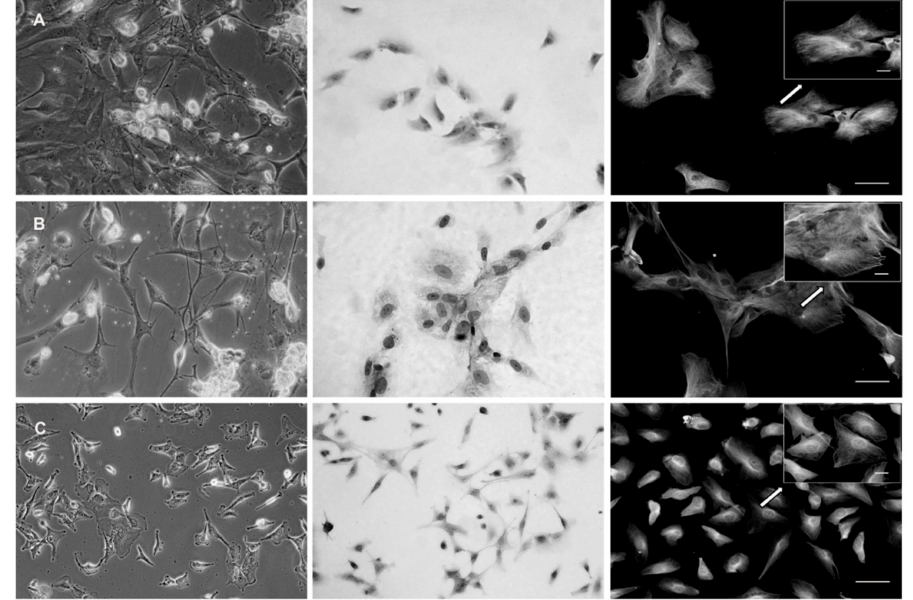
Figure 2. Phase contrast ( left ), haematoxylin and eosin ( middle ), and fluorescence (microtubules) ( right ) of primary glioblastoma cells (GBM1) isolated using enzymatic method ( A ) and mechanic method ( B ). Stabilized glioblastoma cell line A-172 ( C ) was used for comparison. Magnification 200 × , scale 30 µ m, inset images—magnification 400 × , scale 5 µ